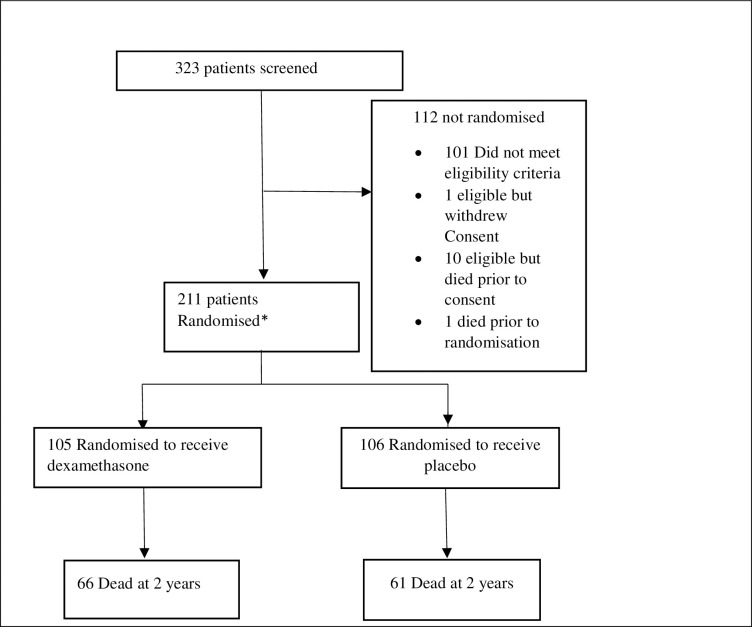
Study flow diagram showing participants enrolled in the CryptoDex trial in Uganda and mortality through two years after initiation of therapy.